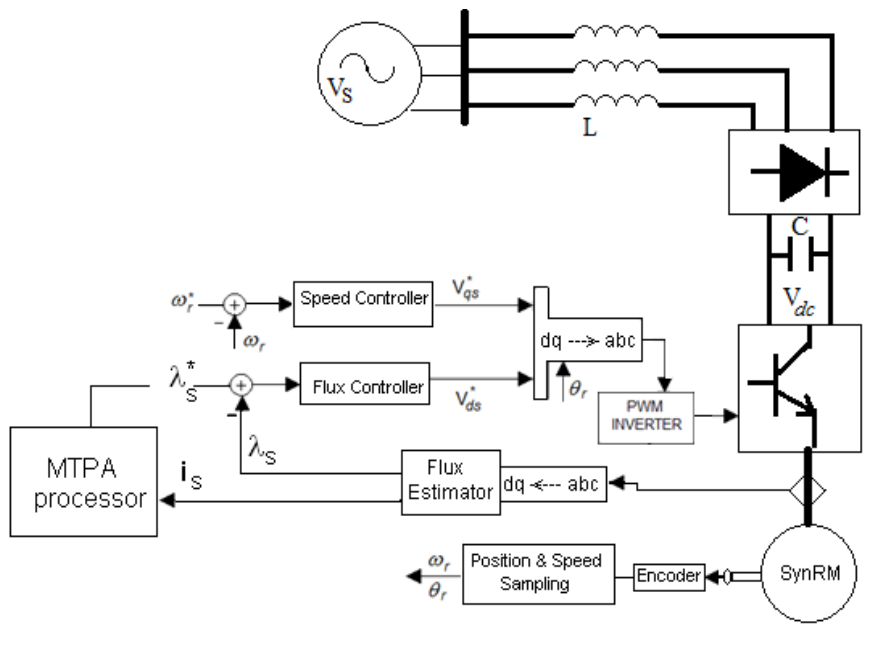
Figure 9. Single-Line Diagram of the Network.